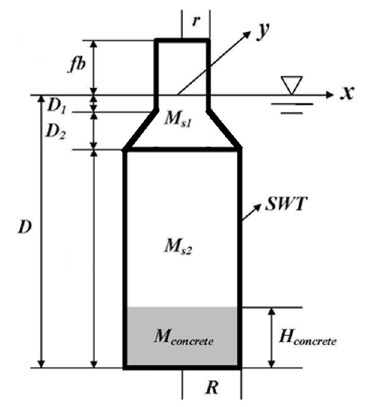
Table 5. Parameters’ influences on the natural frequencies of SWAY model ( ↑ : increase; ↓ : decrease; ﹣ : negligible effect).